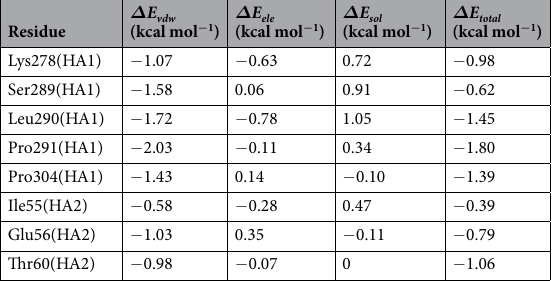
Table 4. Decomposition of binding energy on per residue in new binding site basis on INT-HA 1ruz under acidic conditions.